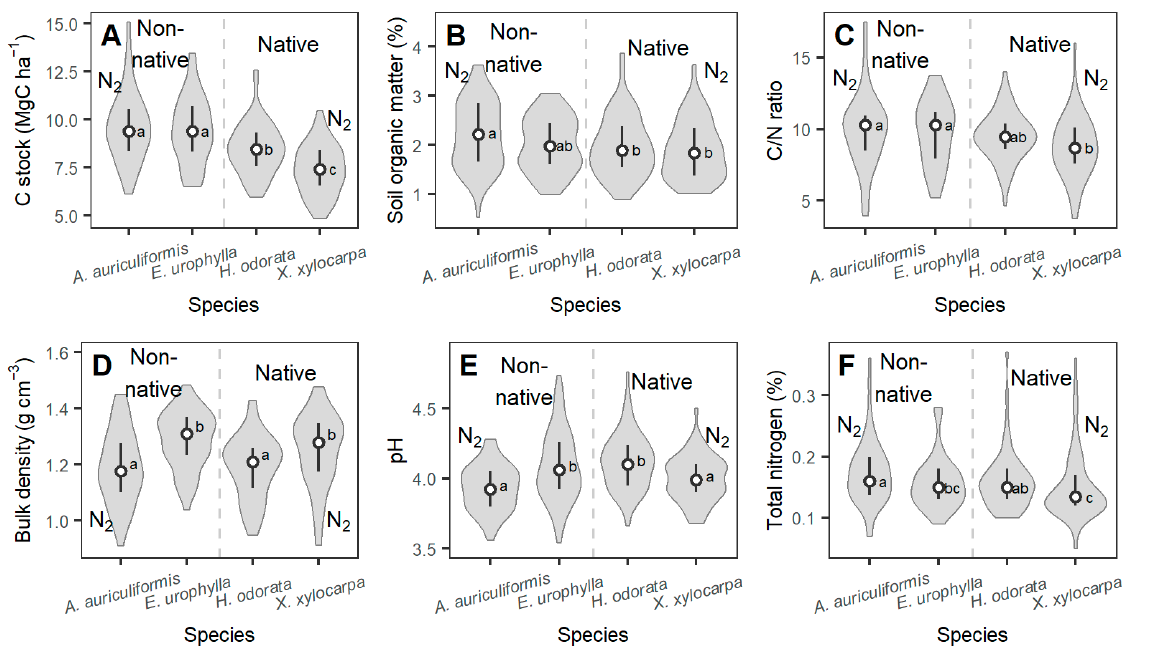
Figure 3. Comparison of soil conditions across the four tree species: ( A ) carbon stock, ( B ) soil organic matter (SOM), ( C ) C/N-ratio, ( D ) bulk density, ( E ) pH, and ( F ) total nitrogen. The dot represents the median value, the vertical lines represent the interquartile range (IQR), and the widths of the violin plots indicate the density of observations at each level. Letters represent significant differences be- tween medians, as determined by Dunn’s test ( p < 0.05).